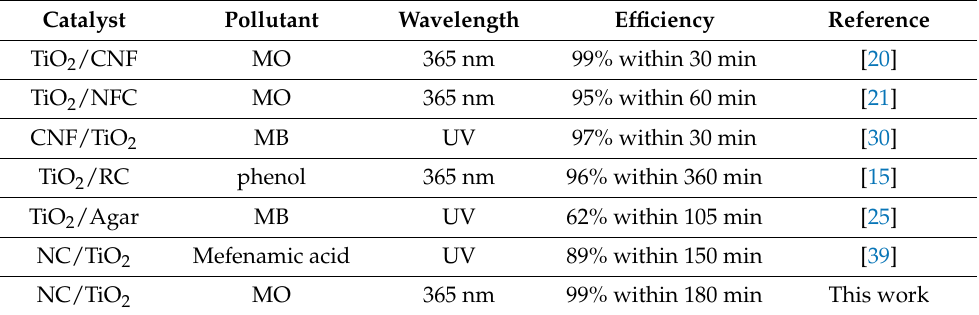
Table 1. Comparison of the photocatalytic efficiency NC–TiO 2 with other reported works for the catalytic degradation of various organic pollutants. Catalyst